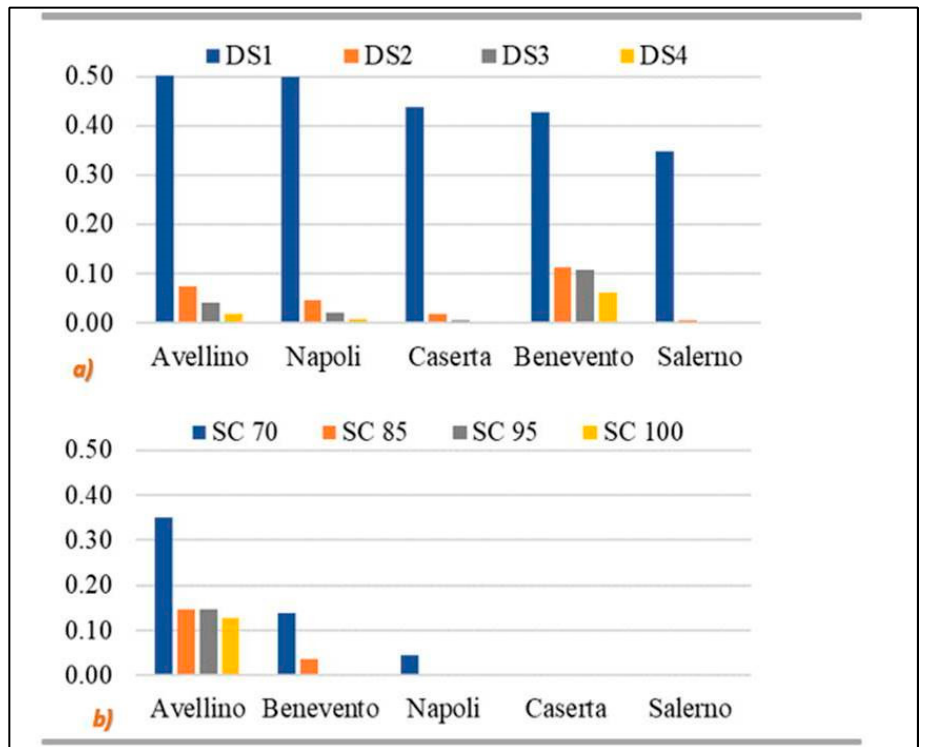
Figure 13. 4-storey building Campania region: ( a ) damage scenario; ( b ) energy quality.